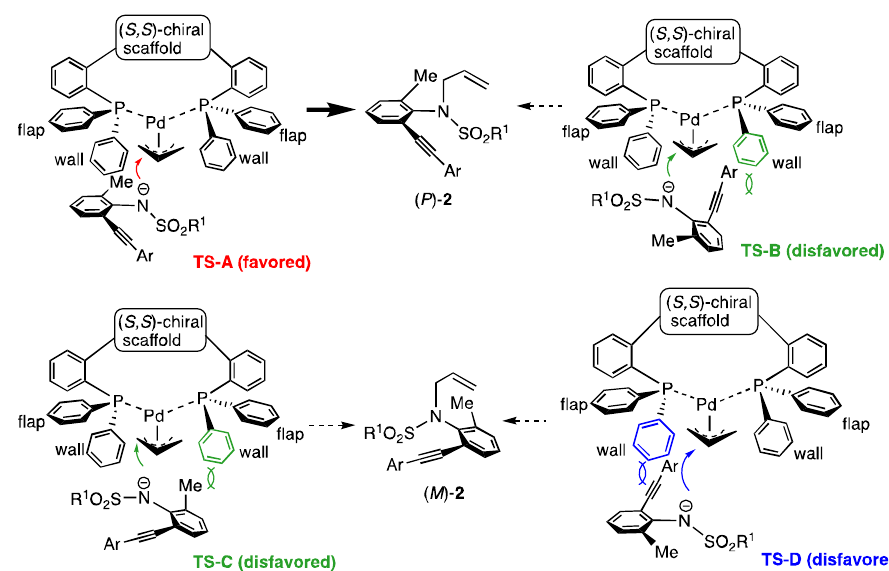
Figure 2. Origin of enantioselectivity in N -allylation with ( S , S )-Trost ligand.